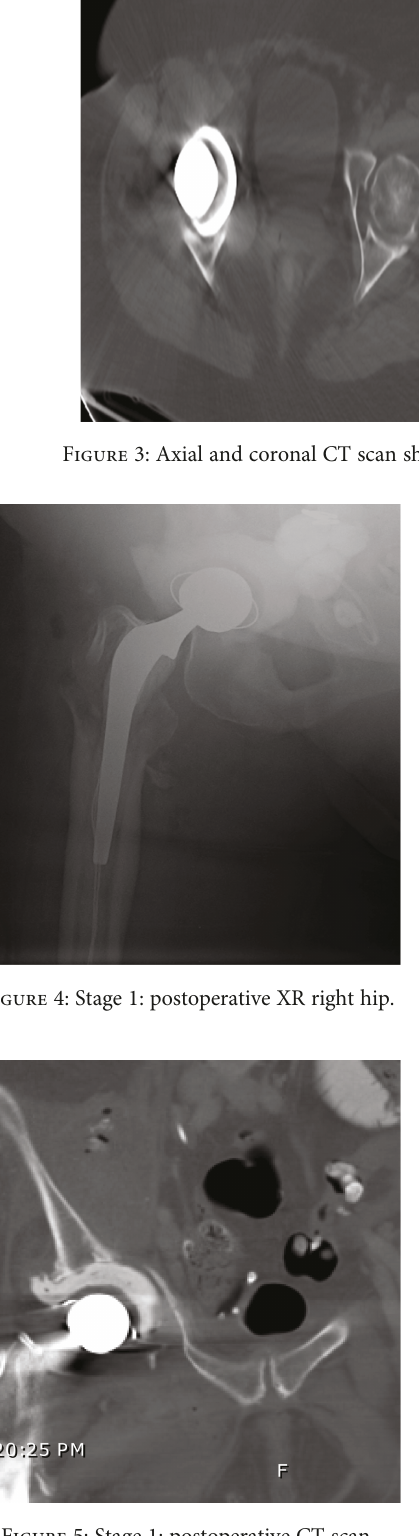
Figure 5: Stage 1: postoperative CT